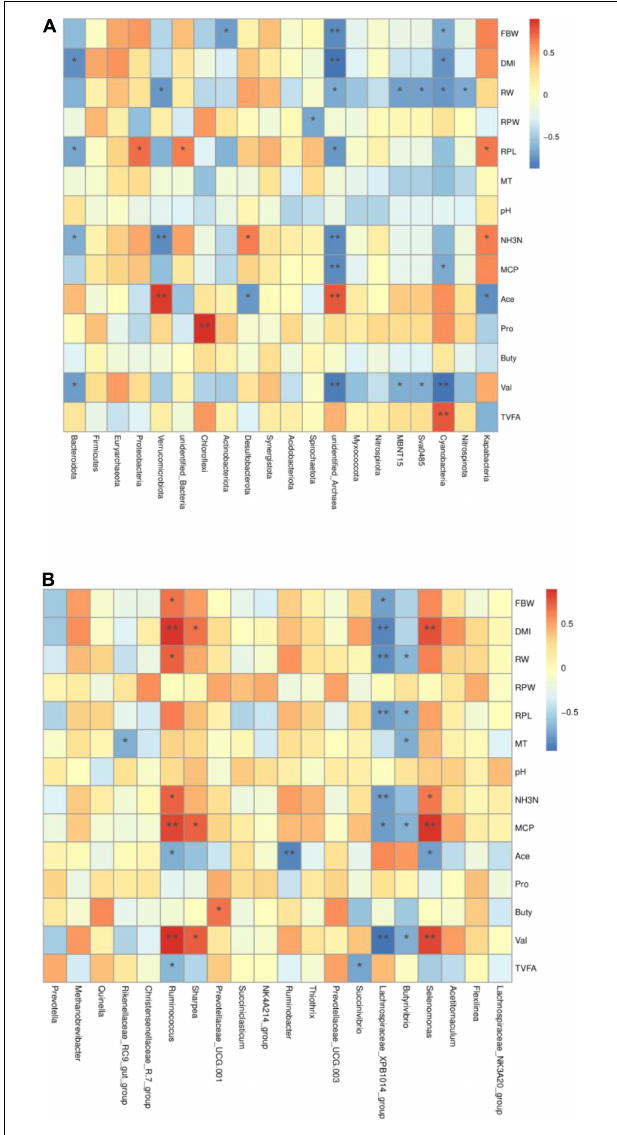
FIGURE 3 | Heatmap of the correlation between microbiota [ (A) phylum and (B) genus] and fermentation parameters in the rumen of yak calves. RBW, finally body weight; DMI, dry matter intake; RW, ruminal weight; RPW, ruminal papilla width; RPL, ruminal papilla length; MT, muscle thickness; NH3N, NH 3 -N; MCP, microbiota crude protein; Ace, acetate; Pro, propionate; But, butyrate; Ibu, isobutyrate; Val, valerate; Iva,